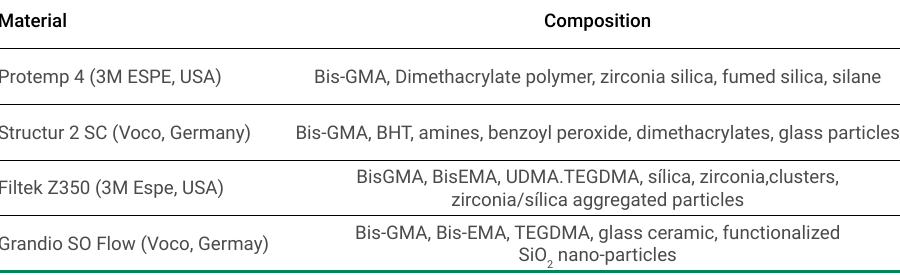
Table 1. Compositions of materials used in this study